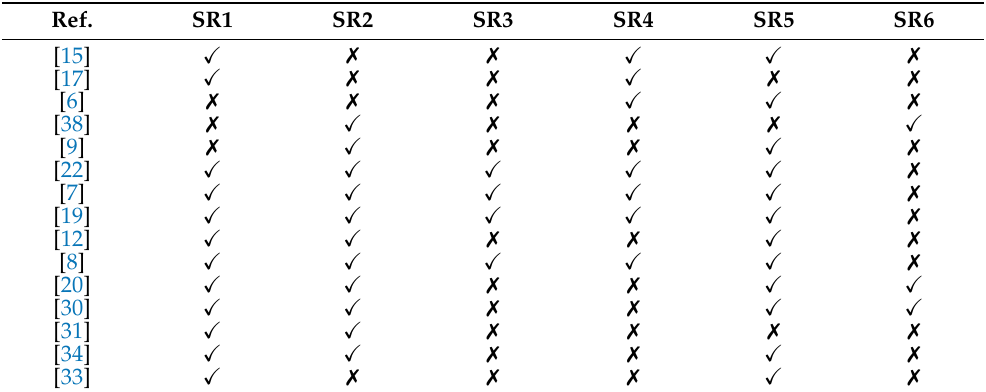
Table 2. Comparative analyses of security